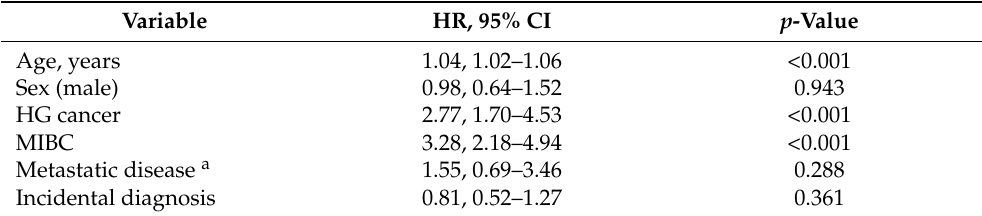
Table 2. Multivariable stepwise Cox regression model investigating associations between specific variables and overall mortality during